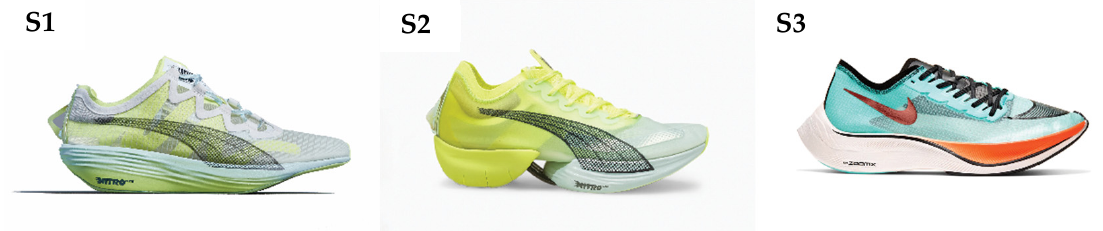
Figure 1. The test shoes used in this study. Left: “Puma Fast-FWD” (S1), Middle: "Puma Fast-R" (S2) and Right: "Nike Vaporfly Next%" (S3).